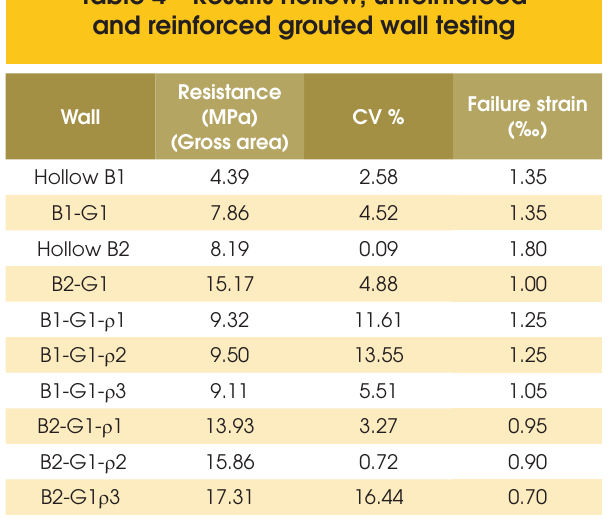
Figure 4 – Scheme of the prisms testing